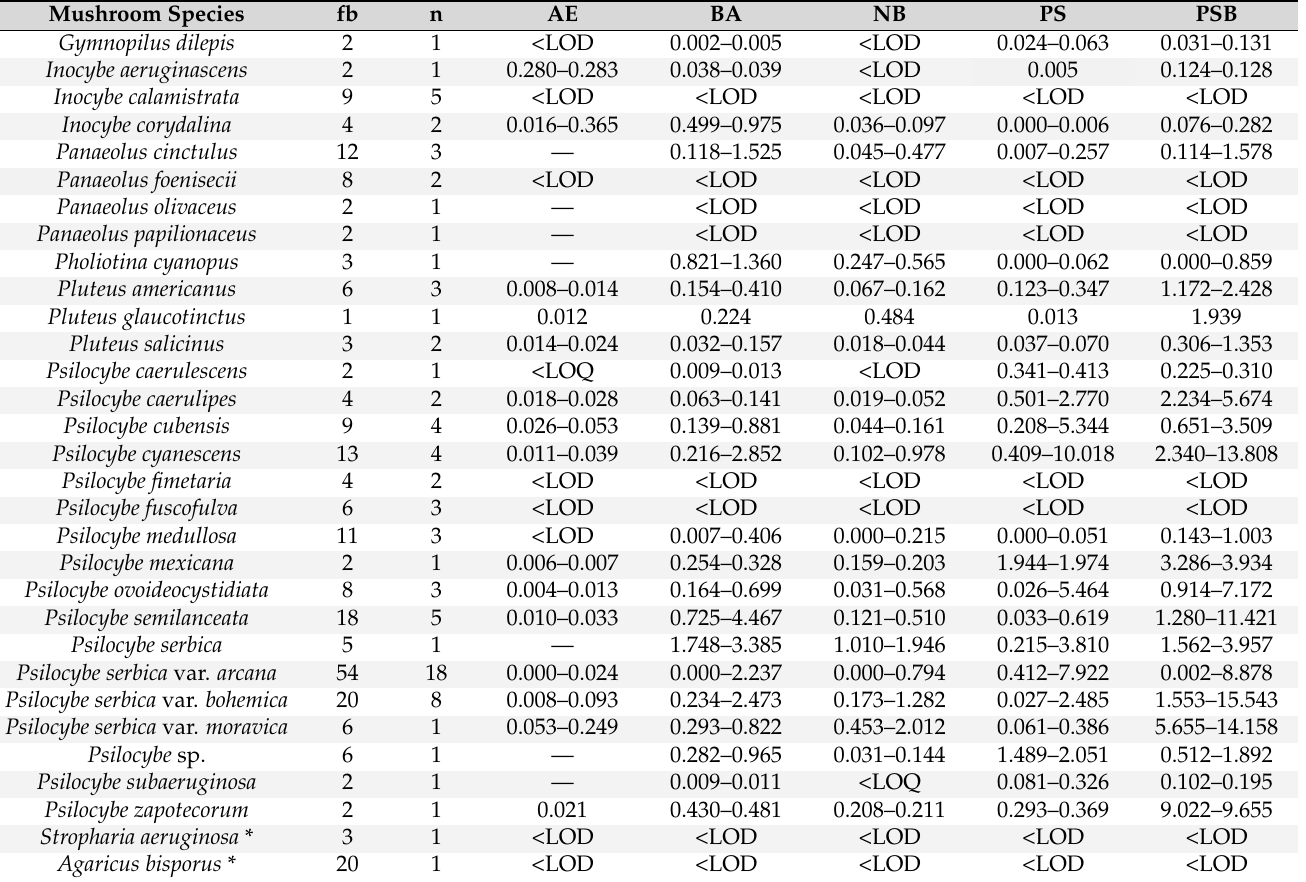
Table 1. Concentrations of tryptamine alkaloids (mg/g in dry mass) in the investigated mushroom species. Aeruginascin (AE), baeocystin (BA), norbaeocystin (NB), psilocin (PS), and psilocybin